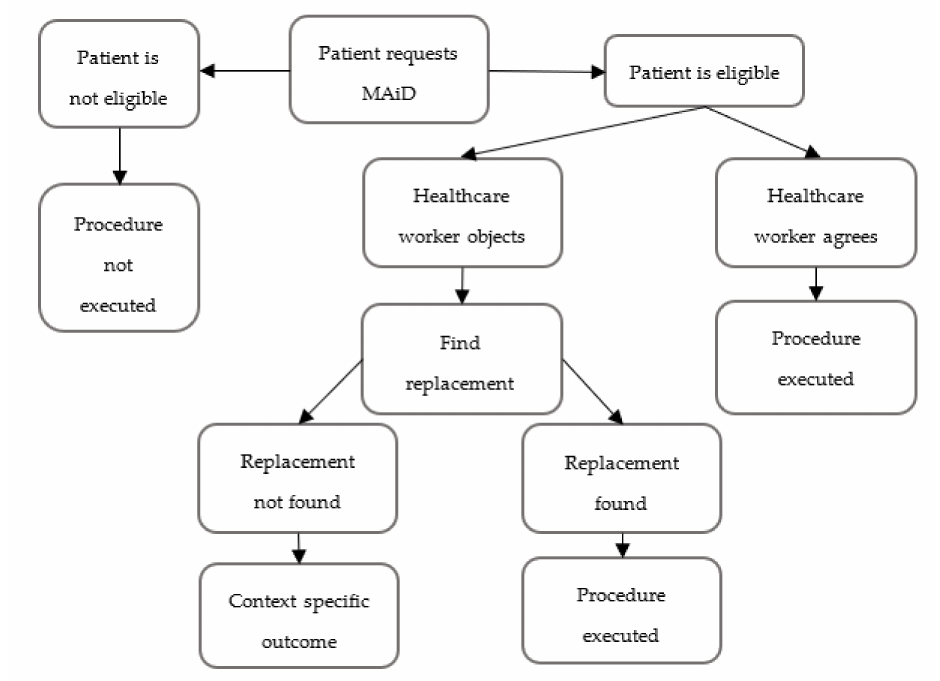
Figure 1. MAiD Decision